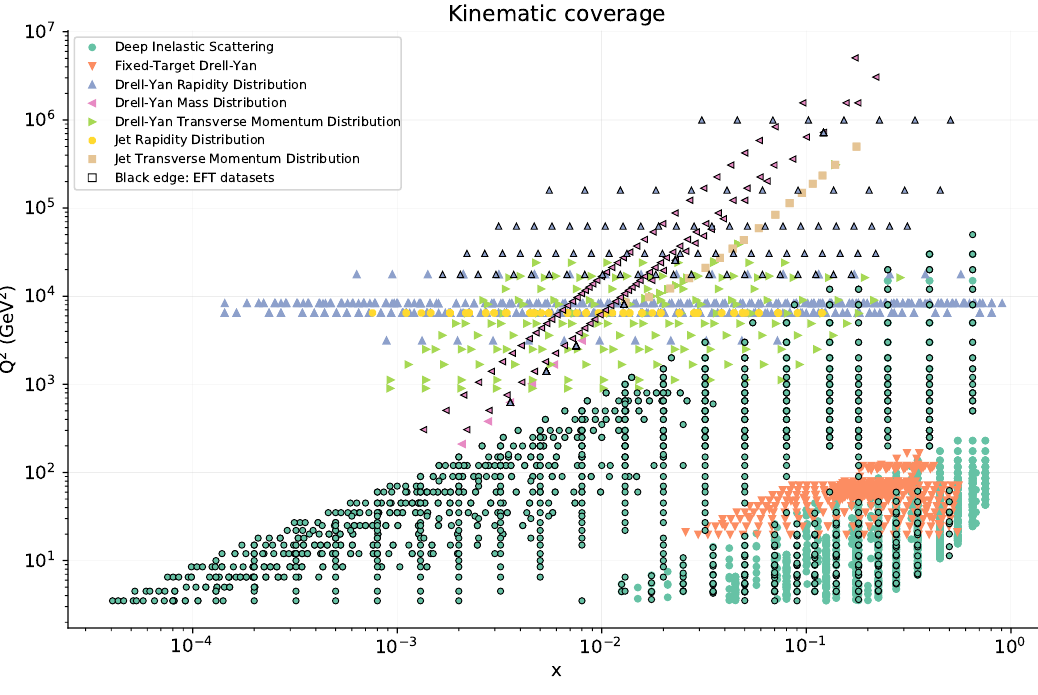
Figure 4 . The kinematic coverage of the data points used in this study grouped according to their process. Points marked with a black edge are also used to constrain the SMEFT operators. Note that the HL-LHC projections used in this study are omitted from this figure, as only actual data are displayed.